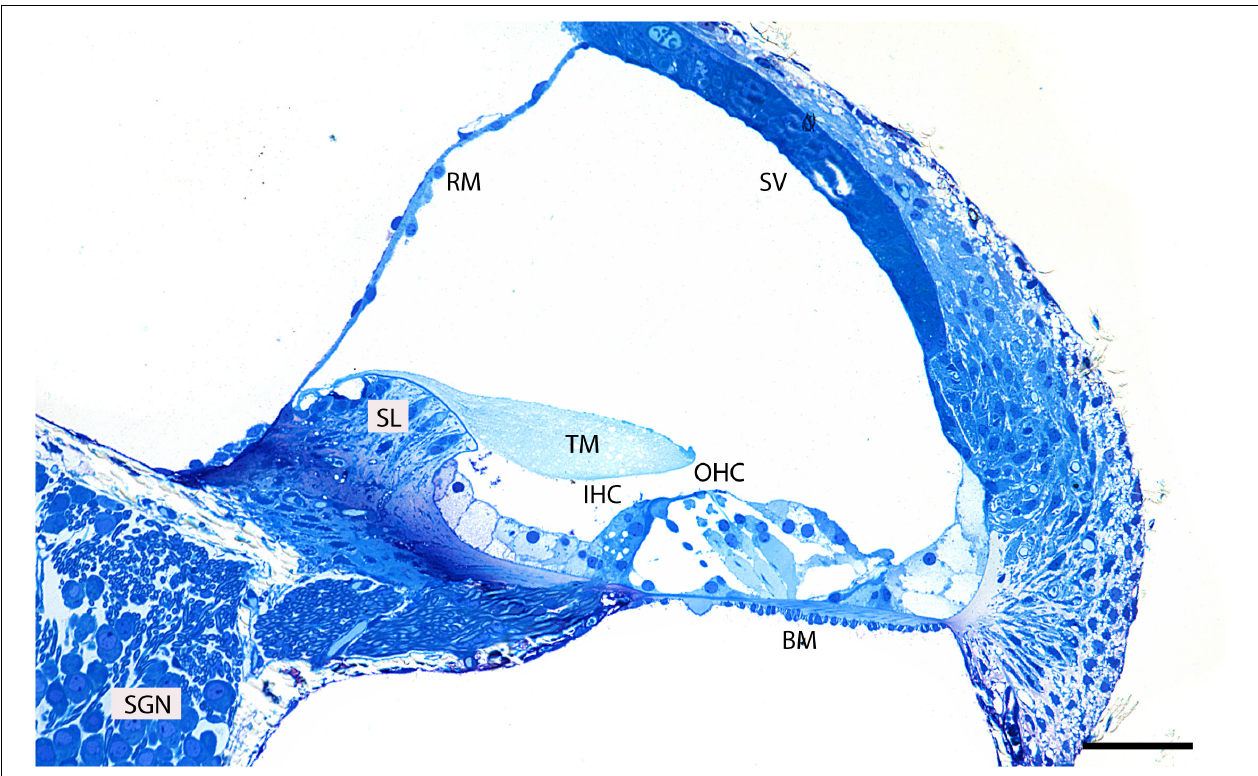
FIGURE 2 | Representative image of a semi-thin (0.5 µ m) methylene blue-stained resin section taken from the middle region of an adult mouse cochlea. Basilar membrane (BM), inner hair cell (IHC), outer hair cells (OHC), tectorial membrane (TM), spiral limbus (SL), Reissner’s membrane (RM), spiral ganglion neurons (SGN), stria vascularis (SV). Scale bar 500 µ